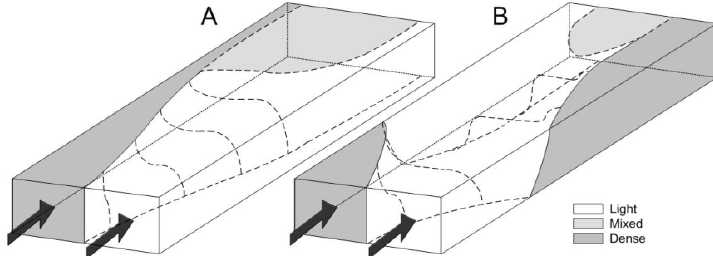
Figure 7. Conceptual picture of the shape of the interface between dense and light water without a velocity difference. The arrows indicate the flow direction and the side where the dense (dark) and light (light) waters enter the confluence area. ( A ) A wide downstream channel ( B ) a narrow downstream